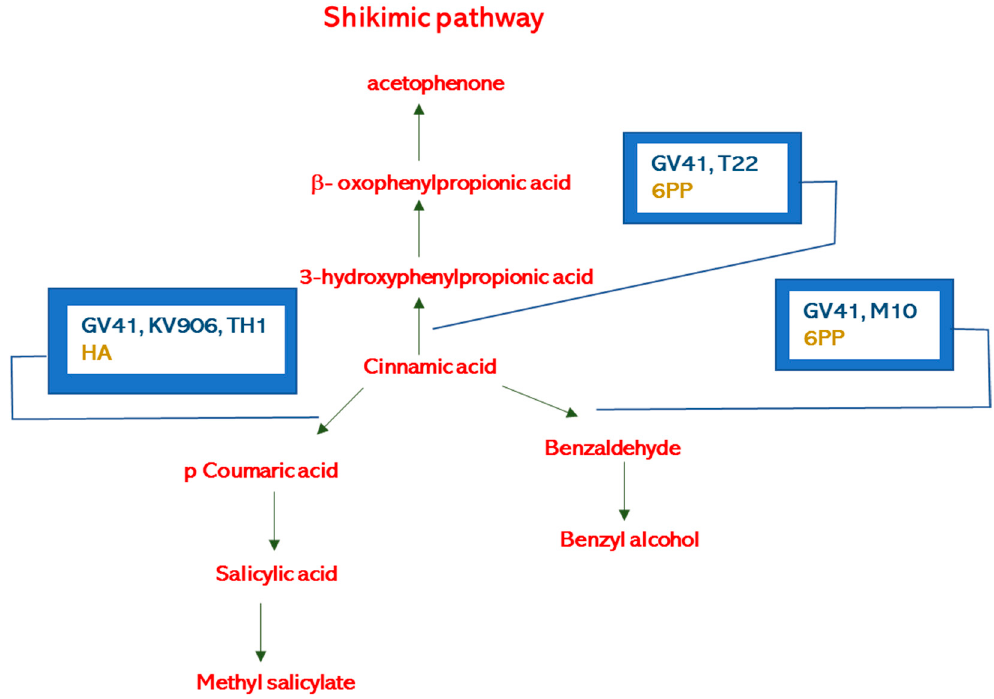
Figure 4. Benzene derivatives biosynthetic pathways and possible influence of Trichoderma strains (GV41, T22, M10, KV906, TH1) or metabolites (HA, 6PP).